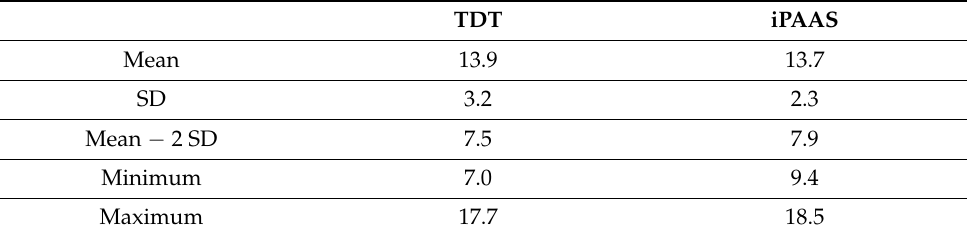
Table 4. Descriptive results for the BMLD thresholds (given in dB) for the laboratory-based system (TDT) and iPAAS